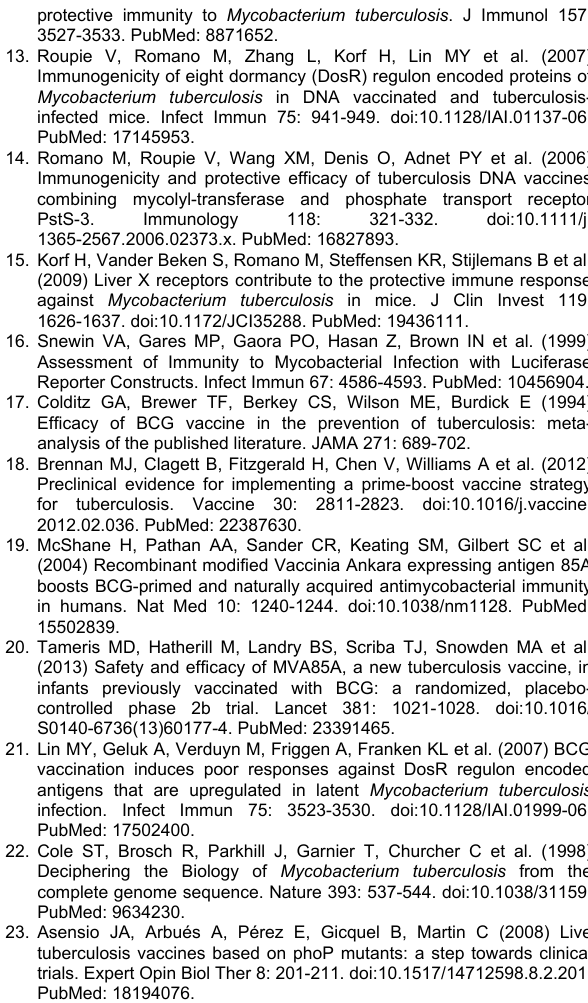
Table S1. Spleen cell IFN-γ production in C57BL/6 mice vaccinated with MGM1991, HMA or BCG vaccine 20 weeks before. IFN-γ level in spleen cell culture supernatant